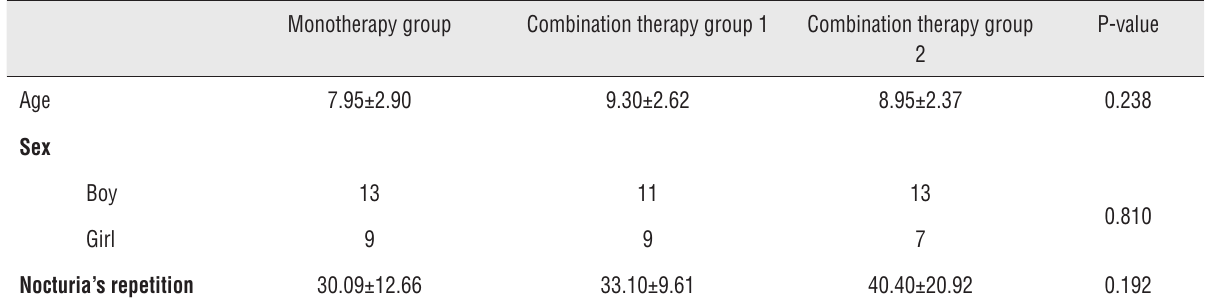
Table 1 - Age, sex and nocturia's repetitions in each group of